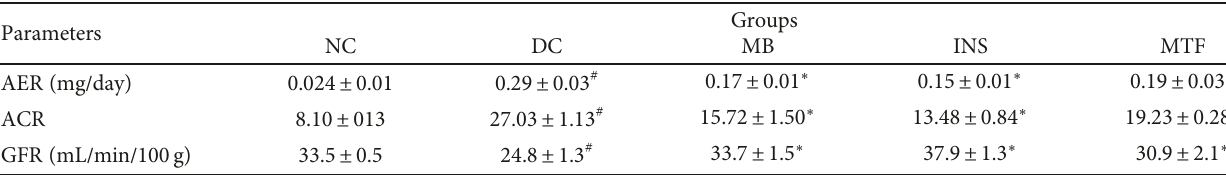
Table 4: Comparison albumin excretion rate (AER), albumin creatinine ratio (ACR), and glomerular fi ltration rate (GFR) of nondiabetic controls, diabetic controls, and diabetic rats treated with MB, metformin, and insulin rats after a 5-week study ( n = 6 in each group). Values are expressed as mean ± SEM .